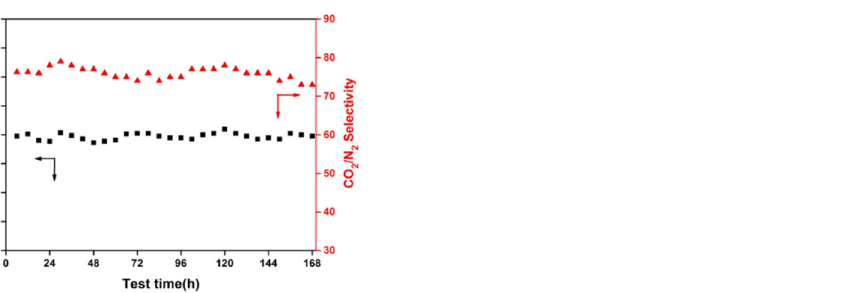
Figure 11. The stability test of the UiO-66@HNT/Pebax (20 wt.%) at 25 °C and 5 bars (feed pres- sure).